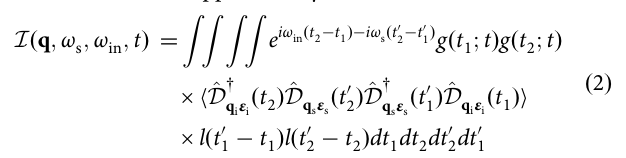
Fig. 1 Probing light-driven spin fl uctuations with resonant inelastic X-ray scattering. a Sketch of a pump – probe resonant inelastic X-ray scattering (RIXS) experiment with π – σ polarization. b Magnon dispersion in the 2D Hubbard model in (blue solid line) and out of equilibrium (red dashed line, pump fi eld amplitude A 0 = 0.6) as determined through the linear spin-wave and Floquet linear spin-wave (FLSW) theory [see Eqs. (7)]. The gray shaded region indicates momenta that are kinematically inaccessible to Cu L -edge